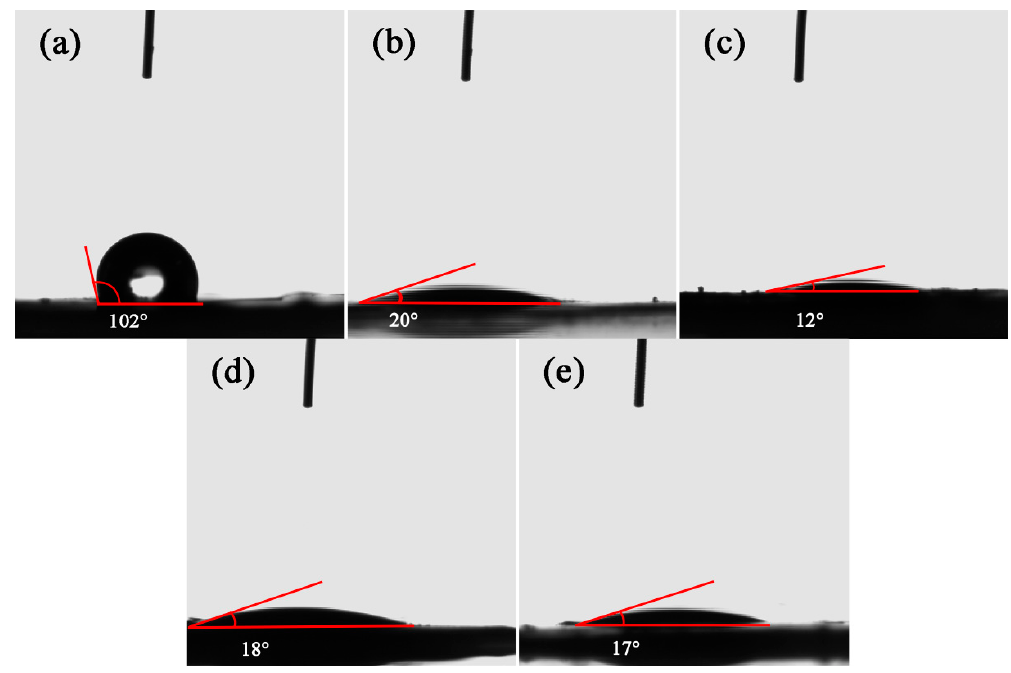
Figure 6. Water Contact angles of ( a ) WS 2 , ( b ) WSO ‐ 5, ( c ) WSO ‐ 30, ( d ) WSO ‐ 60, and ( e ) WO 3 .